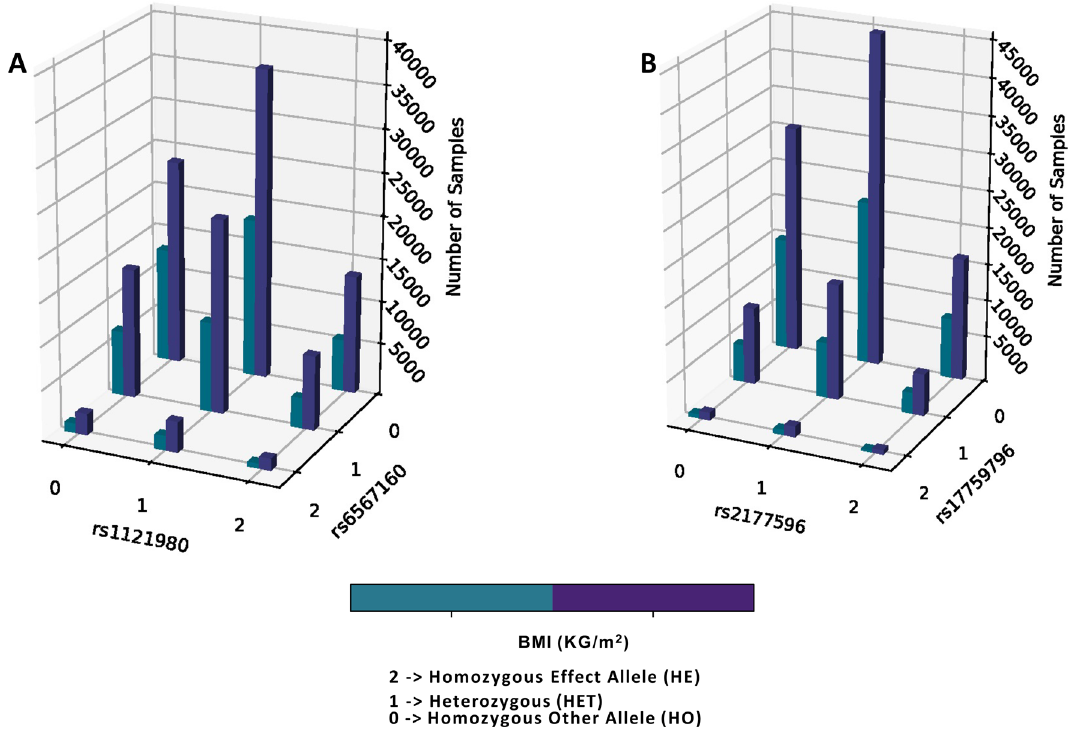
Figure 1. 3-D plot showing three genotypes at each locus for the interacting pairs ( A rs1121980 and rs6567160, B rs2177596 and rs17759796) with respect to BMI prevalence in UKB population. 3D barplot showing prevalence of obesity against genotypes at each interacting locus for two SNP pair interactions: ( A ) rs1121980 and rs6567160, and ( B ) rs2177596 and